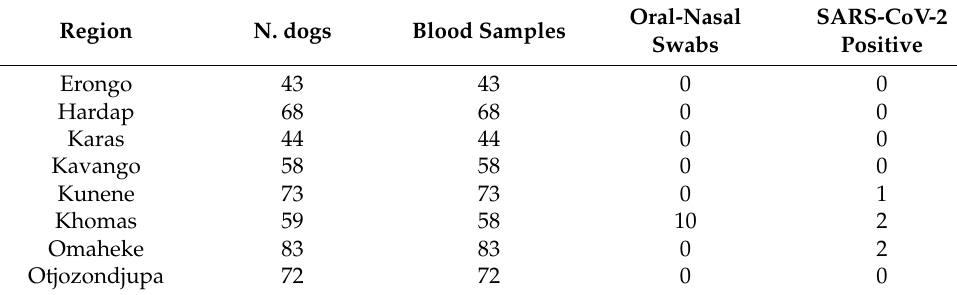
Table 1. Summary of samples’ origins, features and results. Region N.